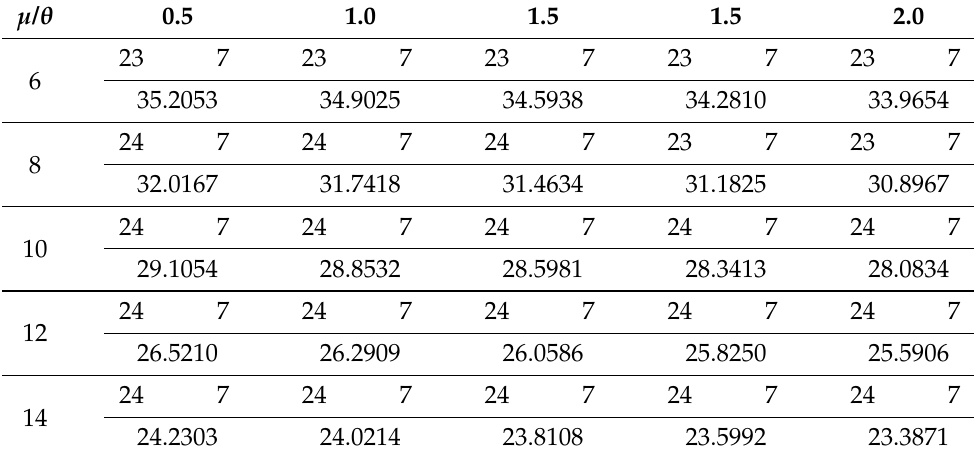
Table 2. Ramification of the rate of lead time ( µ ) and approach from the pool customer ( θ ) on the optimal values.